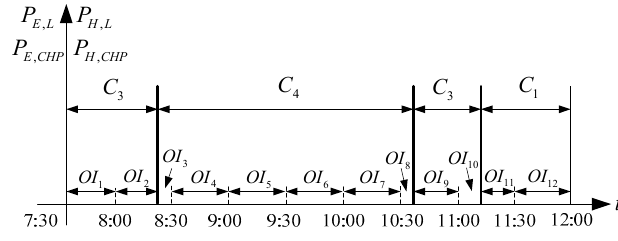
Figure 7. OI s between 7:30 and 12:00.